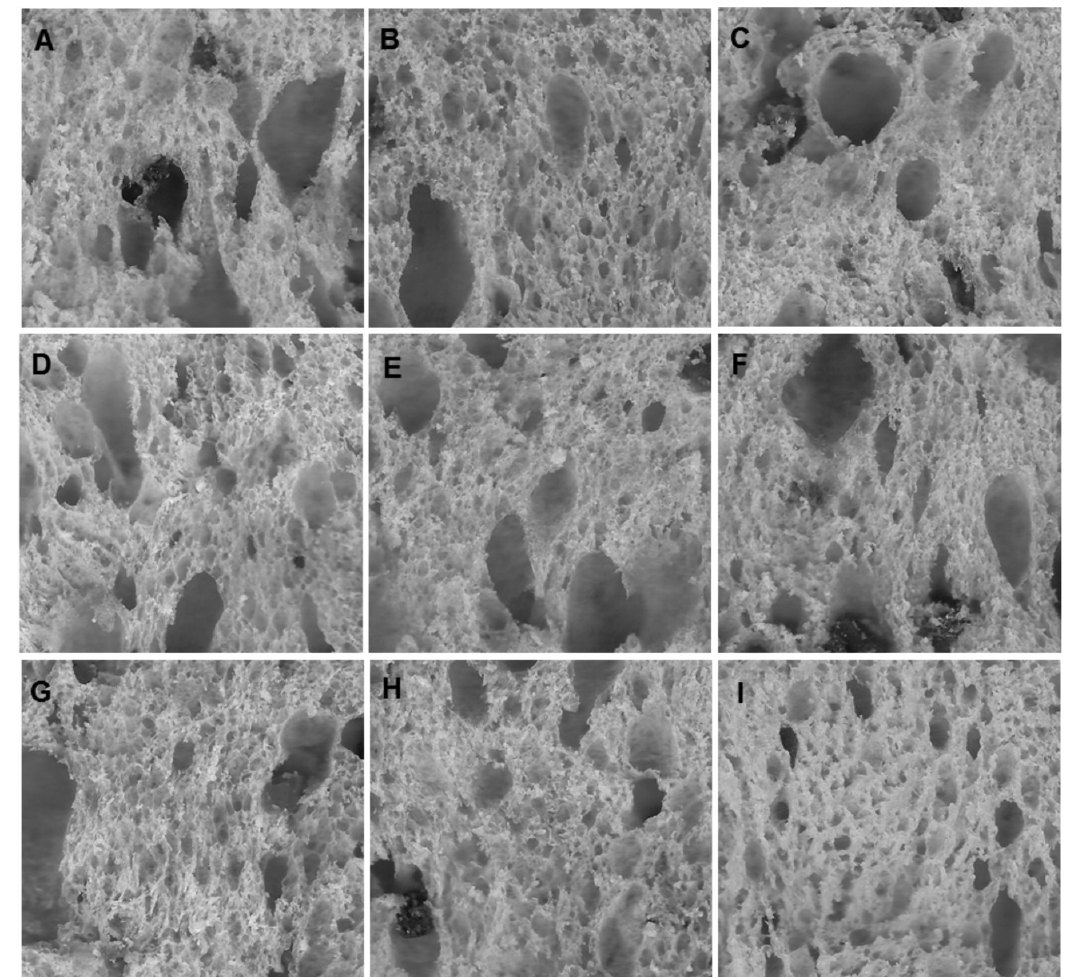
FIGURE 1 – Image analysis of crumb structure of different commercial panettone samples (60 mm x 60 mm